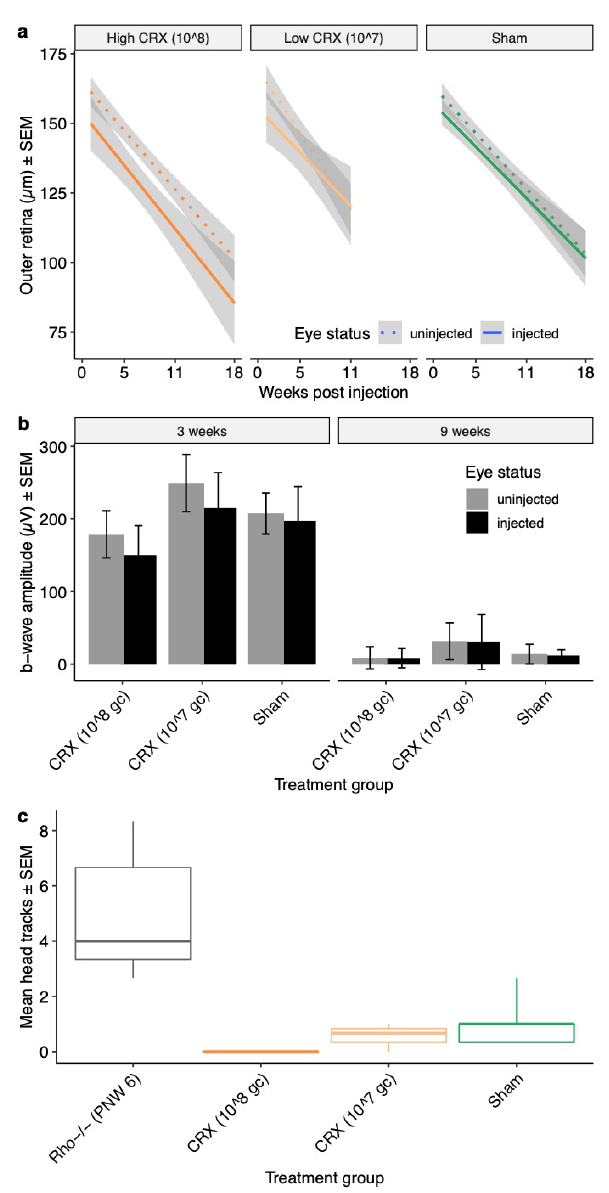
Figure 6. Rescue e ff ect of rAAV.CRX on cone pathway function and retinal structure in Rho − / − , OPN1-GFP mice. ( a ) Average thickness of superior the outer retina during the study period shows equivalent age-related decline in total retinal thickness of uninjected eyes. No group had slower outer retinal loss in the injected eye. All values are mean µ M ± 95% confidence intervals (grey band). ( b ) Light-adapted ERG response to 25 cd.s / m 2 photopic flash stimulus at PNW 6 (3 weeks post injection) and PNW 12 (9 weeks post injection) in Rho − / − , OPN1-GFP mice, comparing b-waves of injected and uninjected eyes. None of the groups showed rescue of ERG function in injected eyes at PNW 12. All values are mean µ V ± SEM. ( c ) OMR in photopic testing conditions of Rho − / − , OPN1-GFP mice 10 weeks following rAAV.CRX or PBS sham injection (PNW13). Uninjected Rho − / − , OPN1-GFP controls at PNW 6 ( n = 5; grey) are included for comparison. There is limited head-tracking behavior in each of the treatment groups and no rAAV treatment group showed rescue of head-tracking behavior. (All values mean head tracks / minute ± SEM bars. For each panel, treatments groups are high dose AAV.CRX (10 8 gc / µ L; n = 14 mice; dark orange), low dose AAV.CRX (10 7 gc / µ L; n = 17 mice; light orange) or PBS sham (n = 17 mice; green).